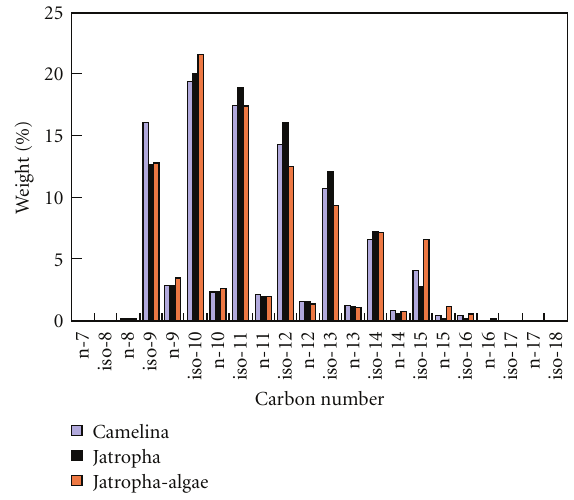
Figure 5: Relative weight percent carbon spectra for camelina, jat- ropha, and jatropha-algae flight fuels blended with JetA-1. Jen-